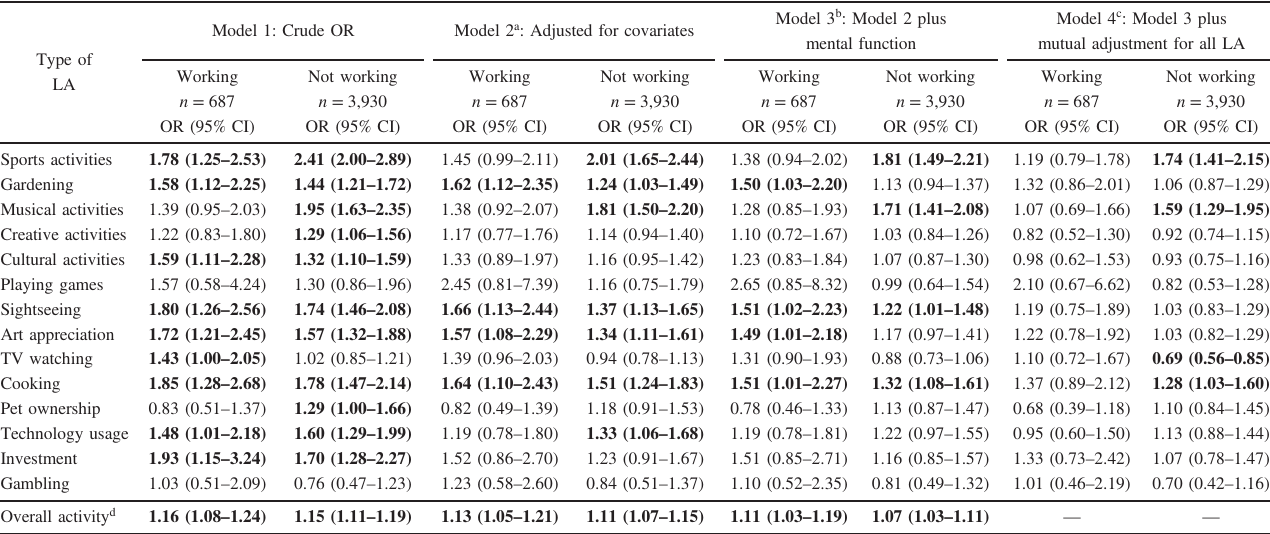
Table 4. Crude and adjusted odds ratios for positive self-rated health associated with the type of leisure activities by work status in